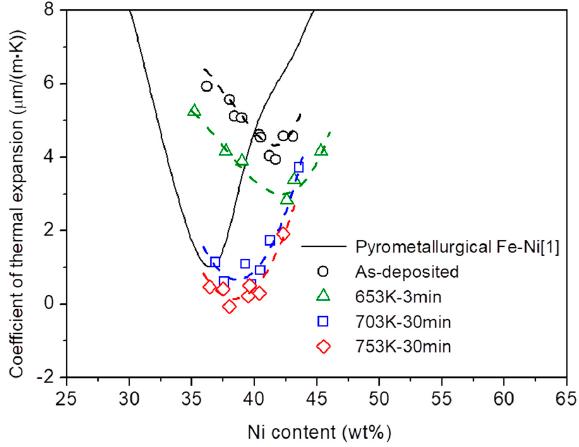
Figure 1. CTEs as a function of the alloy composition. The electroformed Fe-Ni alloys in the as-deposited and as-annealed states exhibit CTEs that differ from those of metallurgically produced Fe-Ni alloys [1]. The CTEs of the as-deposited Fe-Ni alloys are much higher than that of Invar, and the minimum CTE of approximately 4 μ m/(m·K) occurs at a Ni composition of approximately 41 wt %. However, the electroformed Fe-Ni alloys with a Ni content ranging from 36 to 41 wt %, after being annealed at temperatures above approximately 753 K (480 °C) for 30 min, exhibit CTEs lower than that of Invar.